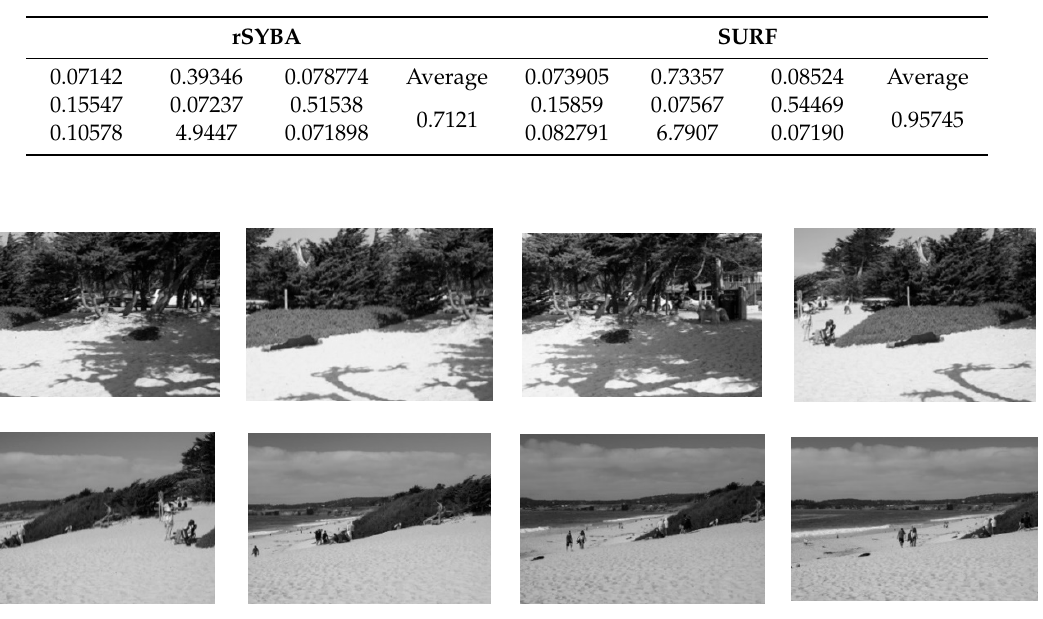
( b ) Figure 13 Image stitching results for ( a ) rSYBA and ( b ) SURF on Carmel image sequence. Table 5. Average relative error results for 3 × 3 homography matrix across all images. rSYBA